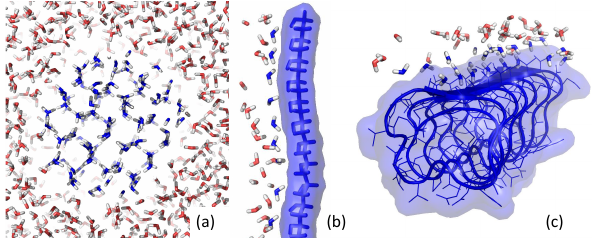
Figure 1. Visualization of water molecule ordering based on molec- ular model calculations (Sect. S2.1): homogeneous ice nucleation (a) ; heterogeneous ice nucleation by ordering of water molecules on a polyvinyl alcohol (PVA) strain, which is a 1-D template (b) , and an antifreeze protein that has a similar sequence and structure as the bacterial INMs, which is a 2-D template (c) . Each image con- tains water molecules that are ordered (blue) and some randomly distributed water molecules